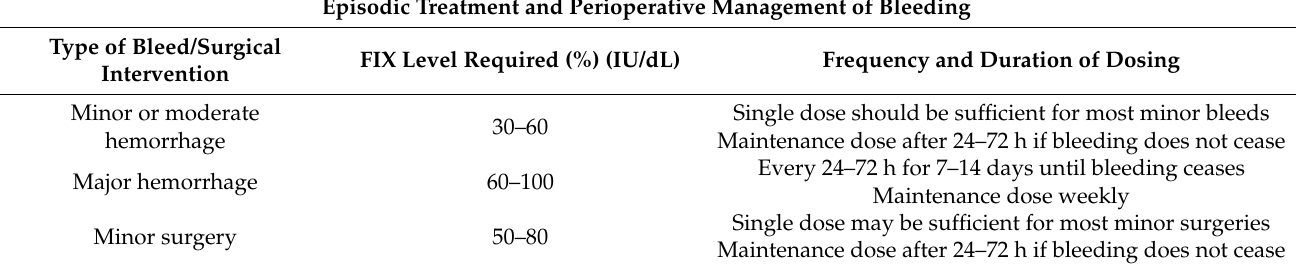
Table 4. Clinical treatment guidelines for